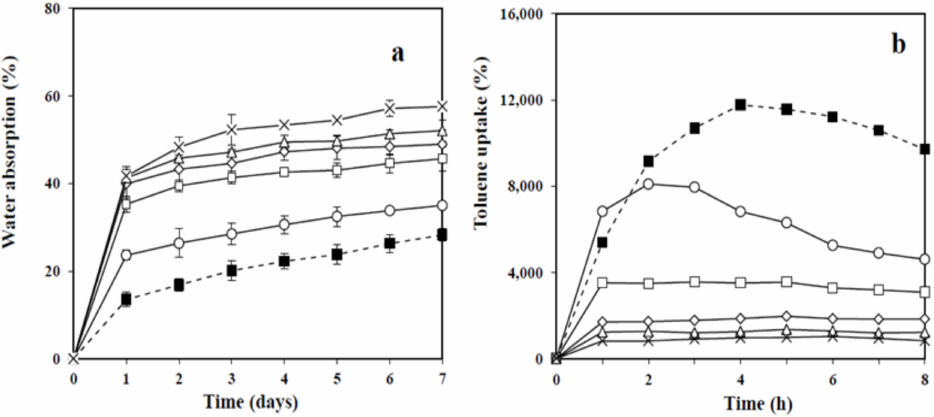
Figure 6. Water absorption ( a ) and Toluene uptake ( b ) of NR and MFC–NR composite films: NR ( (cid:4) ); C10/90 (o); C20/80 ( (cid:3) ); C30/70 ( ♦ ); C40/60 ( ∆ ); C50/50 ( ×